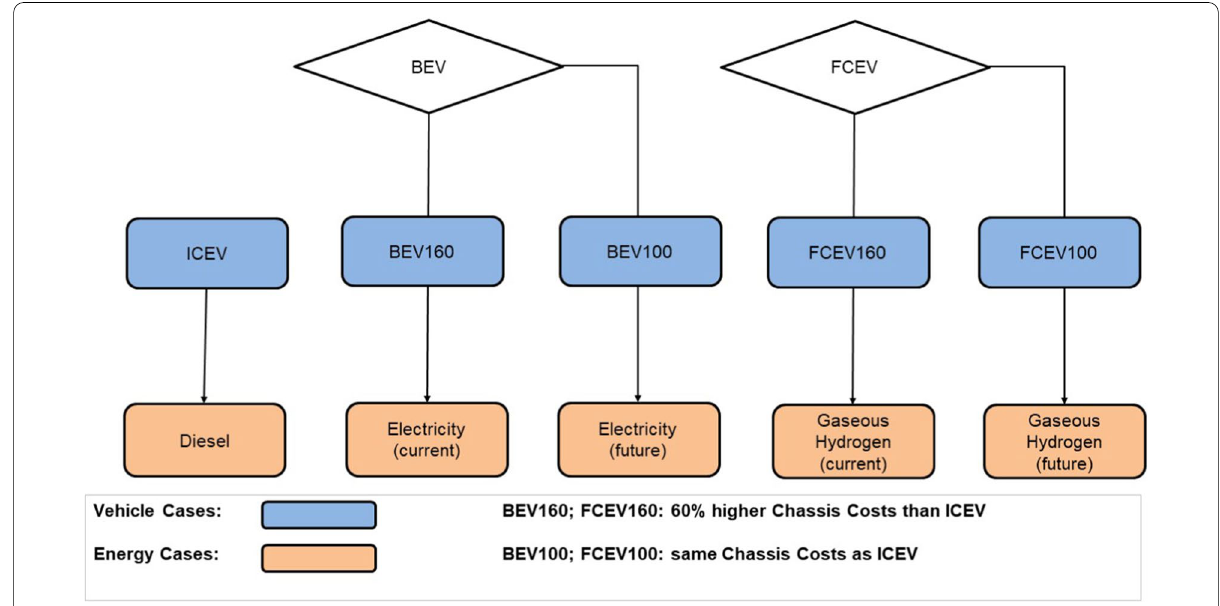
Fig. 1 Overview of vehicle and fuel